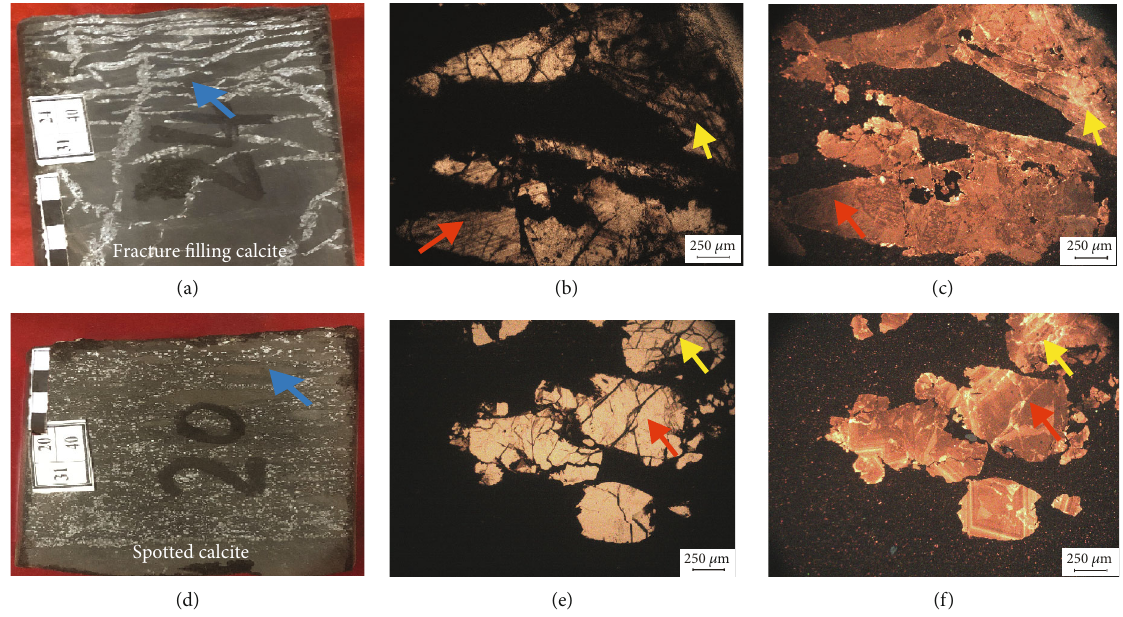
Figure 7: Characteristics of calcite of di ff erent occurrences in Lucaogou Formation, Jimsar Sag: (a) fracture fi lling calcite (J10025, 3707.9m, P l 2 1 ); (b) colorless under single polarized light (J10025, 3707.9m, cathode luminescence (J10025, 3707.9m, P 2 l 1 ); (d) spotted calcite (J10025, 3707.7m, P 2 l 1 ); (e) colorless under single polarized light (J10025, 3707.7 m, P 2 l 1 ); (f) dark red (red arrow) and orange yellow (yellow arrow) under cathode luminescence (J10025, 3707.7m, P 2 l 1